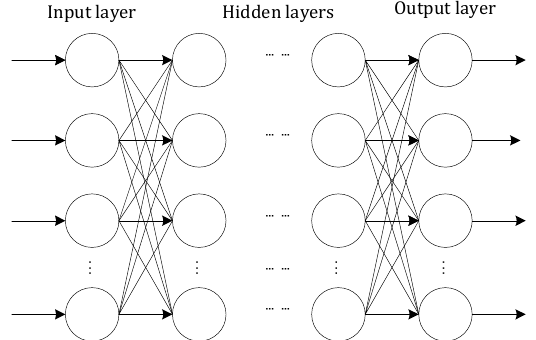
Figure 2. Calculation principle diagram of Back Propagation Training Artificial Neural Network(BP ‐ ANN).